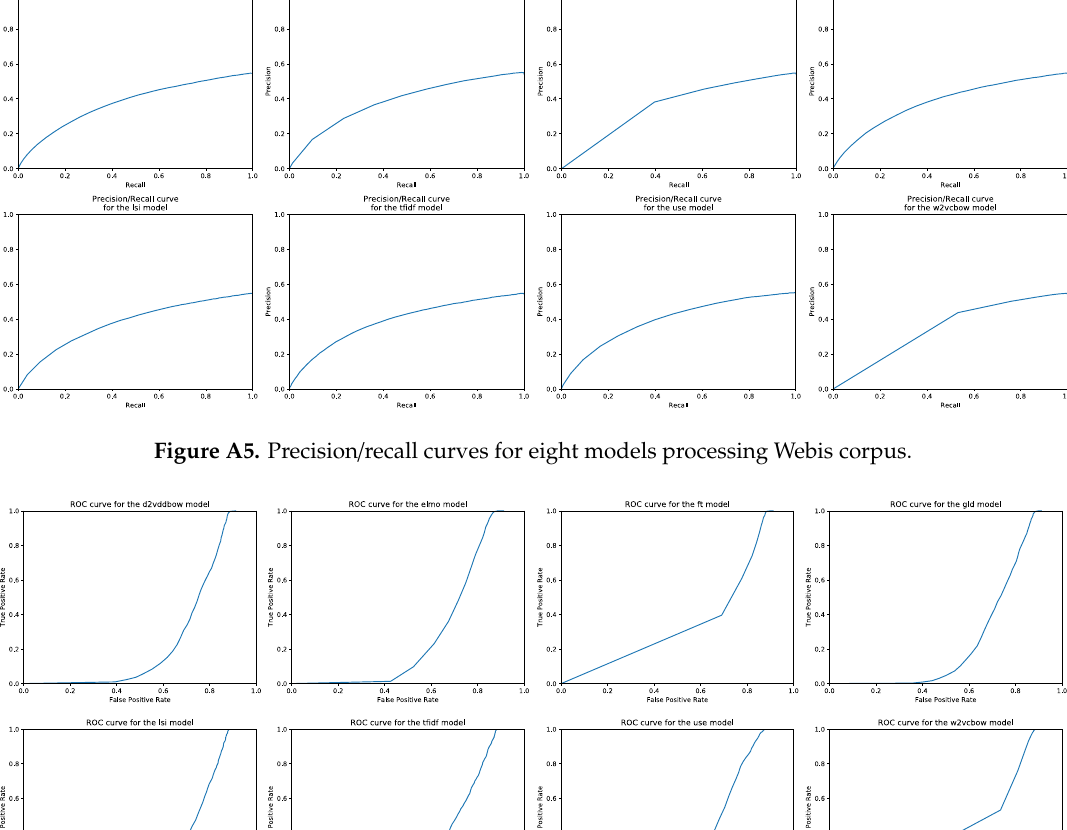
Figure A4. Receiver operator characteristic curves for eight models processing MSRP corpus. Information 2020 , 11 , x FOR PEER REVIEW